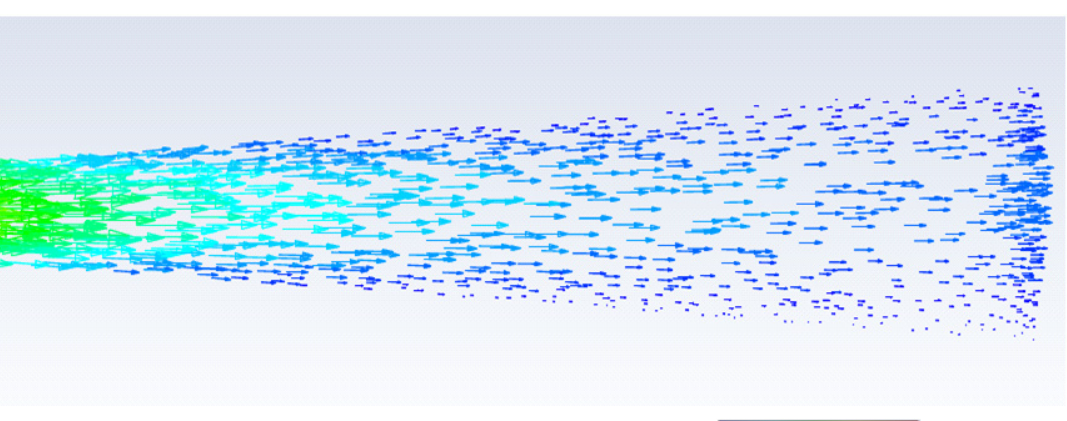
Figure 10. The velocity vectors for cases of different water and air flow